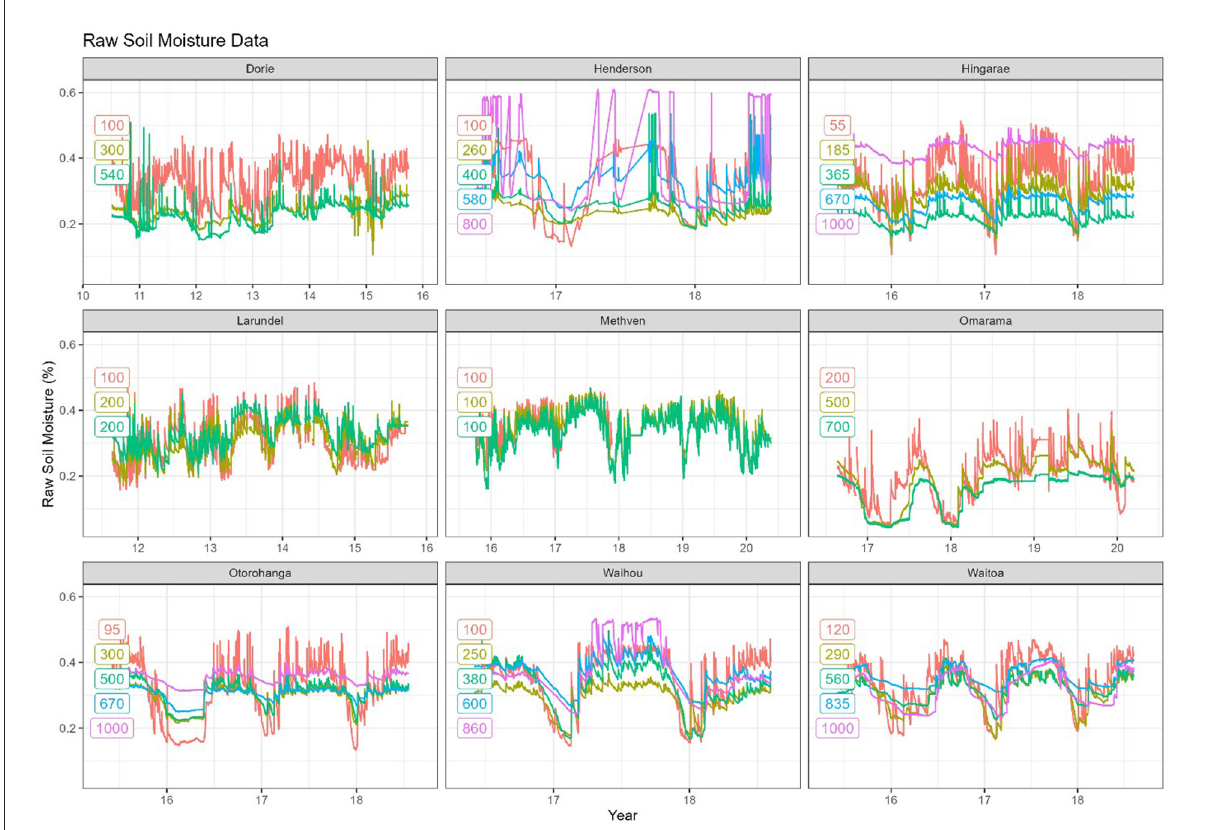
FIGURE4 Soil water content data at each site. Sensor depths (mm) are shown as colored labels.